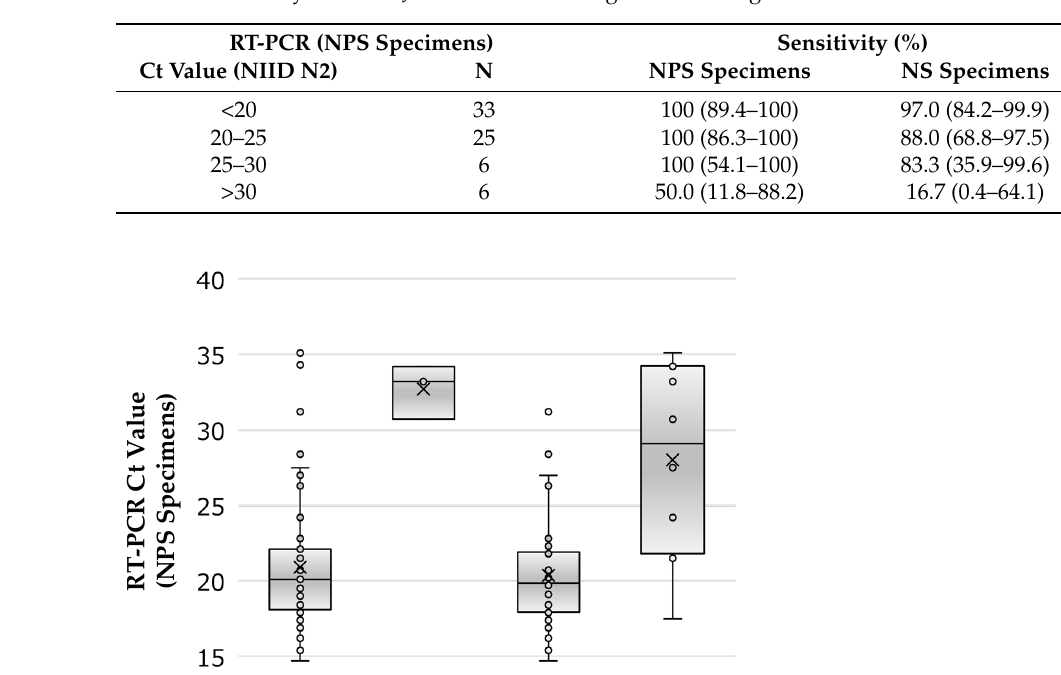
Table 6. Sensitivity of the FUJIFILM COVID-19 Ag test according to the study period. Table 5. Sensitivity of the FUJIFILM COVID-19 Ag test according to the Ct value.